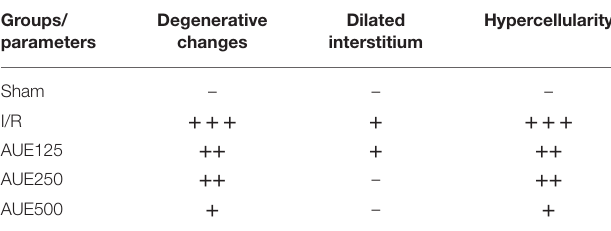
TABLE 3 | Histological changes related to the degree of presence or absence of degenerative changes, dilated interstitium, and hypercellularity of cardiomyocytes.